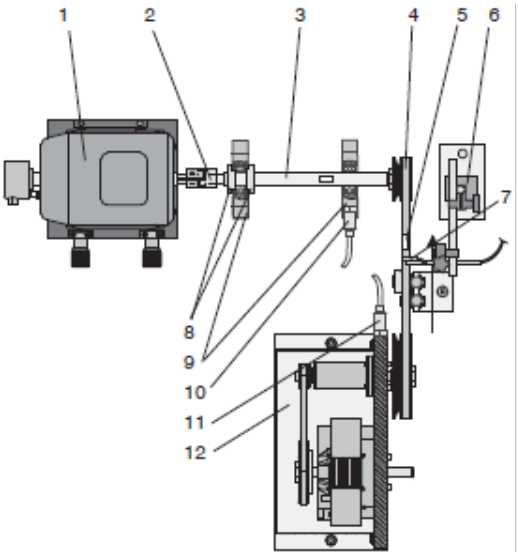
Figure 2. Setup for simulation of vibrations from belt drive. It consists of drive unit (1), elastic claw coupling (2), short shaft (3), small belt pulley for belt drive with V-belt (4), reflective mark on the V-belt (5), magnetic clamp with steel plate (6), reference sensor aligned with reflective mark on V-belt (7), setting rings for axial attachment (8), bearing block (9), acceleration sensor 1 and 2 (10/11), and brake and load unit (12).